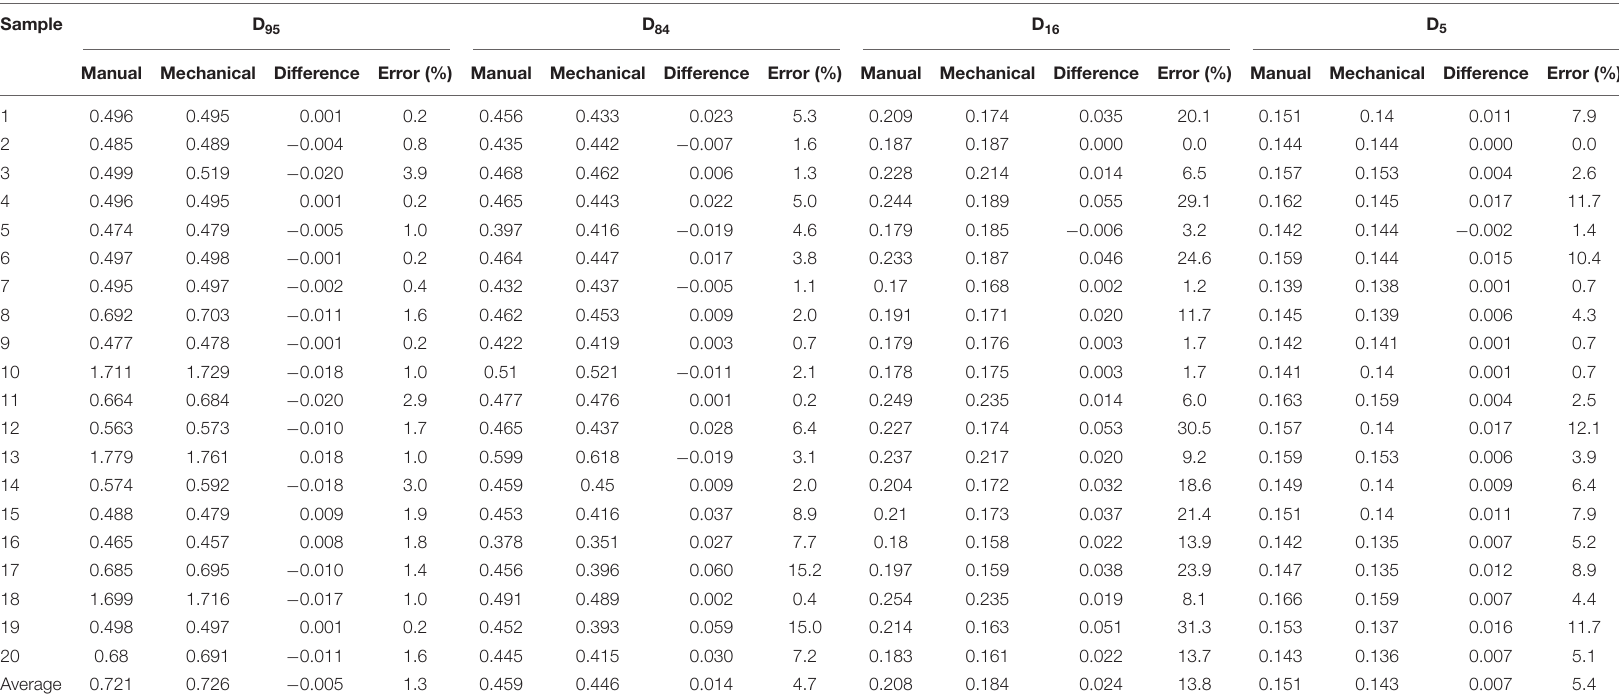
TABLE 3 | Granulometric parameters of 20 sand samples including D 95 , D 84 , D 16 , and D 5 (mm), and difference (mm) and error (%) between methodologies for mechanical and manual sieving methods with 10 cm diameter sieves.